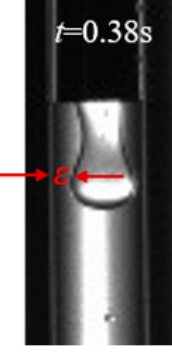
Figure 7. The NaAlg micro-droplet evolution in the squeezing stage ( n 2 = 0.162, Q d = 2 mL/h, Qc = 40 mL/h).